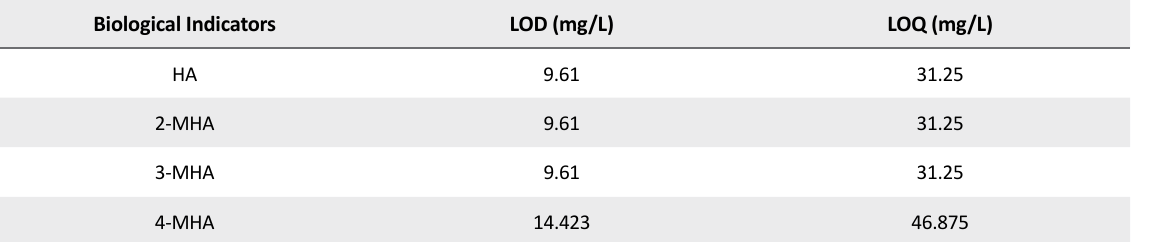
Table 3 . LOD and LOQ studied biological indicators Biological Indicators